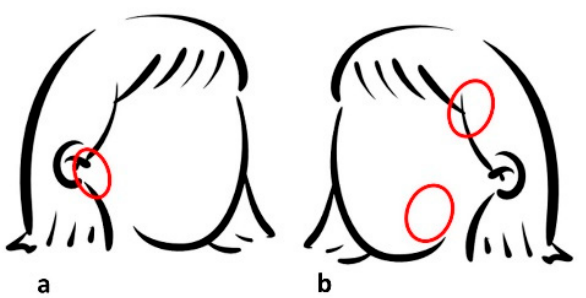
Figure 3. Pain locations across the head and neck region: ( a ) temporomandibular joint; ( b ) craniofacial area.